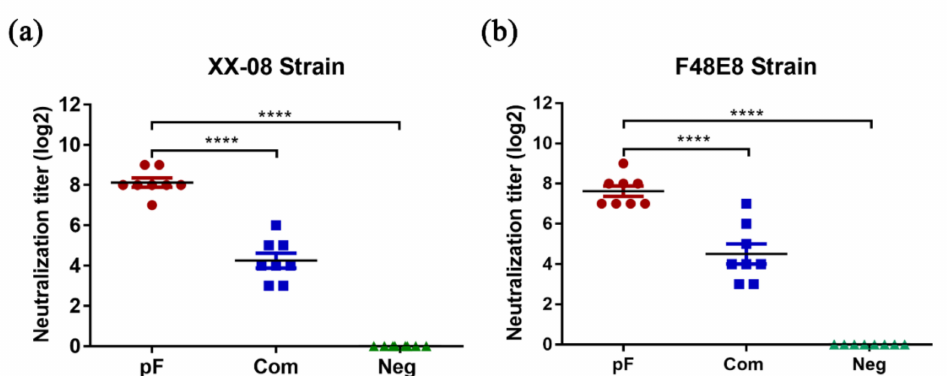
Figure 5. Neutralizing antibody titers in chicken sera before virus challenge were detected by two genotypes of NDV. The XX-08 strain is homologous ( a ) and F48E8 ( b ) is heterologous to the plant-produced F. The pF group (red) was vaccinated with plant-produced F protein. The Com group (blue) was inoculated with commercial live vaccine (LaSota strain). The neg group (green) was inoculated with non-transgenic rice. p < 0.0001